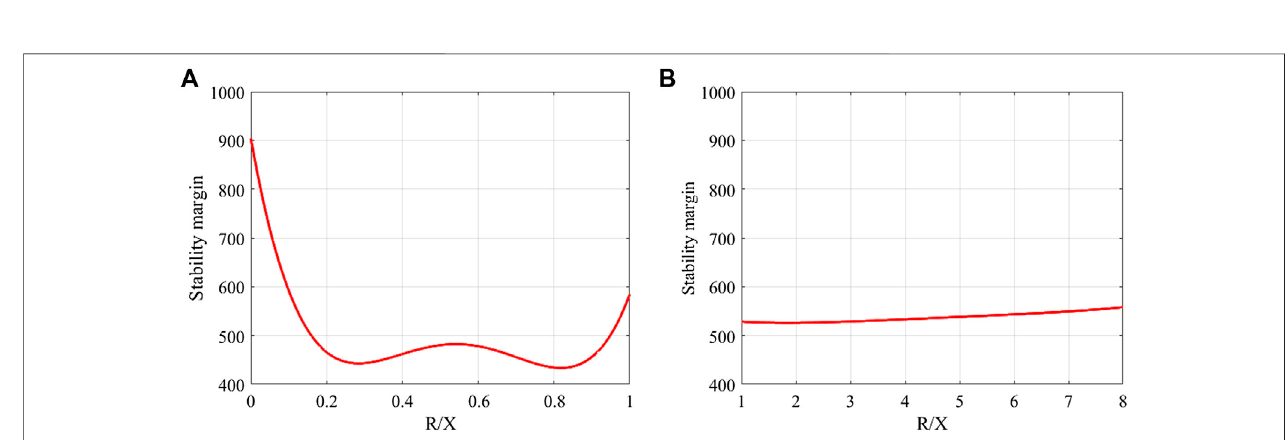
FIGURE 6 | Relationship between impedance ratio and stability margin (PQ node): (A) R/X ratio is smaller than 1, (B) R/X ratio is larger than 1.